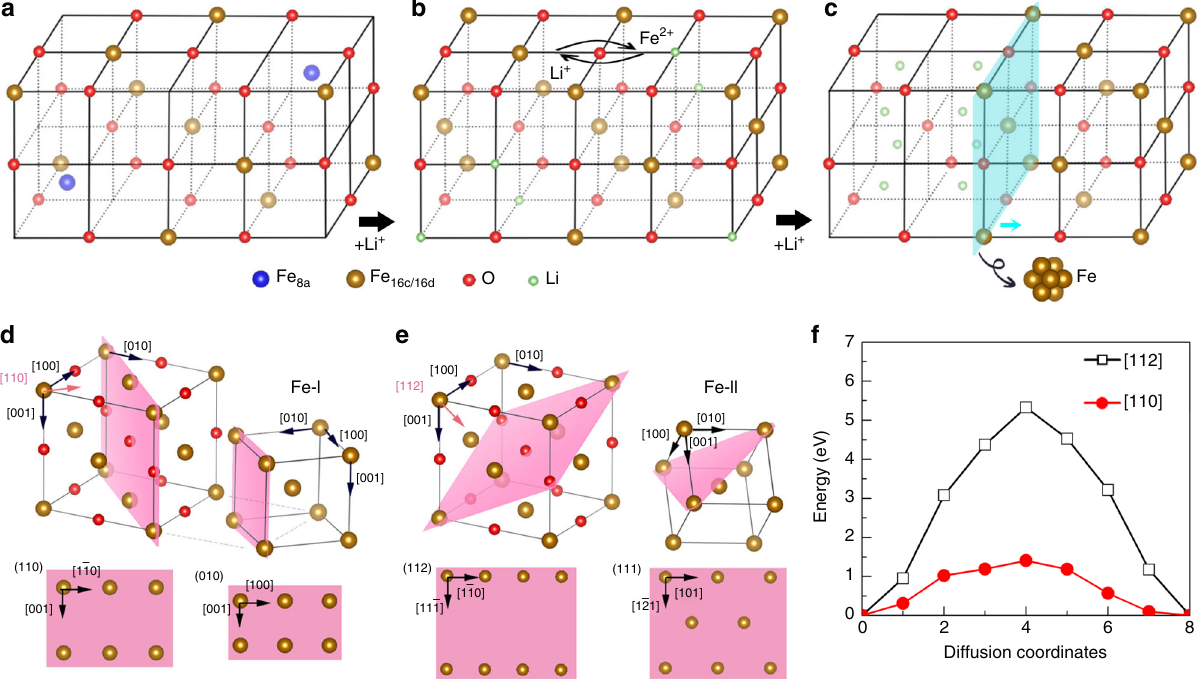
Fig. 4 Ionic transport during the topotactic reaction in Fe 3 O 4 . a – c Schematic illustration of co-operative transport of Li and Fe ions, and consequential atomic re-arrangement within the ccp O-anion framework. The O-framework is retained throughout the entire transformation process, from the initial Fe 3 O 4 , to intermediates of Li x Fe 3 O 4 , FeO, and fi nal phases of Li 2 O and Fe (further elaborated in Supplementary Fig. 6). During initial lithiation, Li insertion into 16c sites leads to migration of Fe from 8a to 16c sites, turning Fe 3 O 4 ( a ) to Li x Fe 3 O 4 ( b ). Further lithiation causes local segregation of Li and Fe ions (marked by the arrows in ( b )), and consequently the formation Li 2 O and FeO (left and right, respectively in ( c )), with an interface between the two (marked by a cyan plane). Continuous lithiation leads to the growth of Li 2 O domains and so the propagation of the interface to the FeO side (marked by a cyan arrow in ( c )), and concomitantly the nucleation of Fe from the interfacial region. d , e Atomistic models for the diffusion of Fe ions along two directions, [110] and [112] (indicated by pink arrows), which leads to cationic re-arrangement towards forming Fe-I and Fe-II, respectively within the ccp framework. The interface planes perpendicular to the Fe diffusion directions are marked using pink color. f Energy barriers of Fe diffusion along the two directions, namely [110] (red) and [112] (black), computed using the structure models in ( d ) and ( e ), respectively. The calculated atomic structures of the involved intermediates are given in Supplementary Fig.